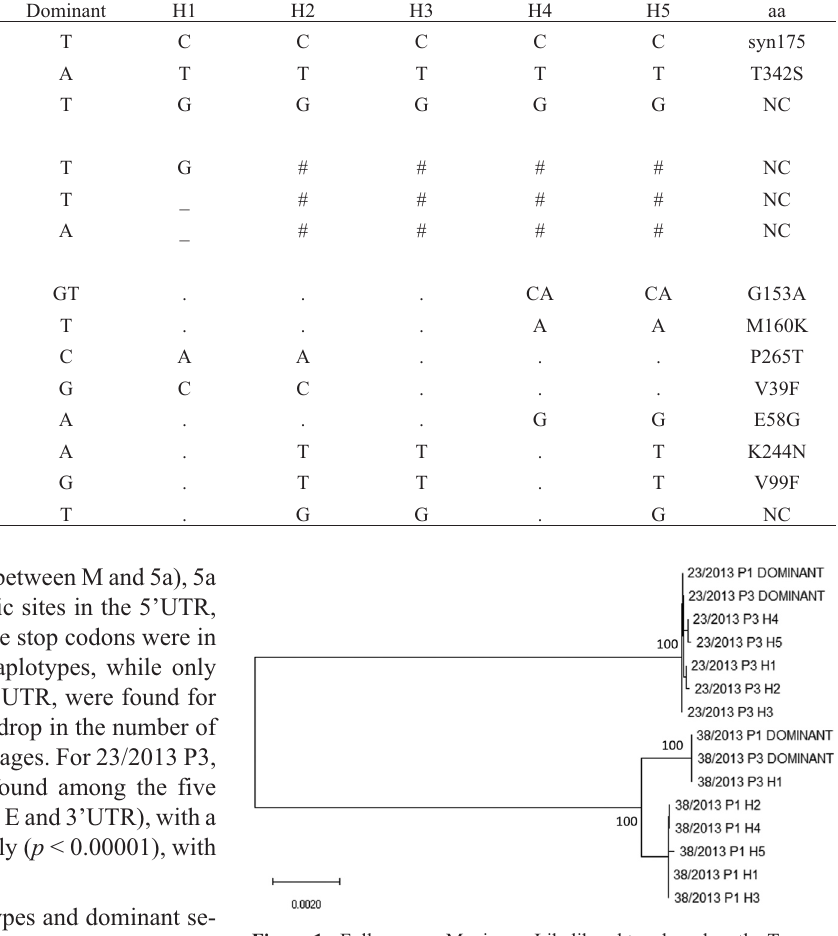
Figure 1 - Full genome Maximum Likelihood tree based on the Tamura- Nei model for variant haplotypes (H) and dominant sequences of AvCoV strains 23/2103 and 38/2013 P1 and P3. The tree with the highest log like- lihood (-41,512.06) is shown. A discrete Gamma distribution was used to modelevolutionaryratedifferencesamongsites[5categories(+G,param- eter = 0.7532)]. The rate variation model allowed for some sites to be evolutionarily invariable ([+I], 77.34% sites). The tree is drawn to scale, with branch lengths measured in the number of substitutions per site. The numbers at each node are bootstrap values (only values = 100 are shown); the bar represents the number of substitutions per nucleotide